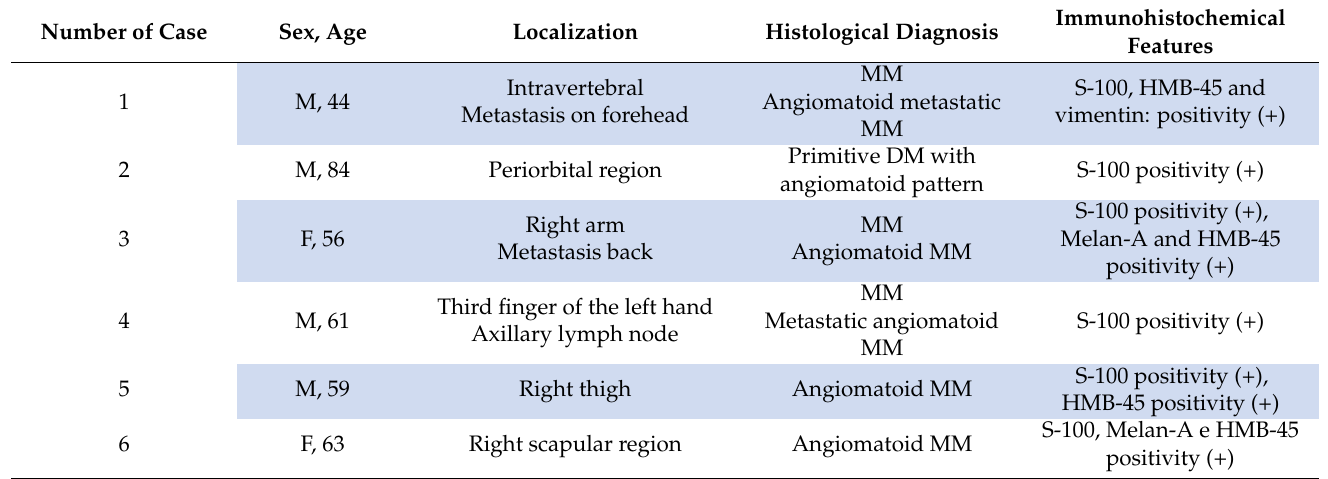
Table 1. Review of the cases of angiomatoid malignant melanoma previous described in literature. Immunohistochemical Localization